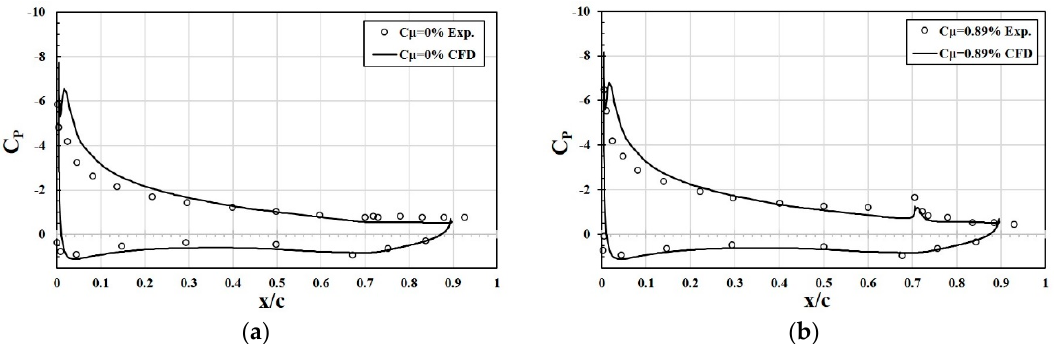
Figure 8. Validation of numerical results for pressure coefficient using experimental data (Melton et al. [18]) for the NACA 0015 airfoil with a flap and fluidic oscillators (x 0 /c = 0.7, α = 8°, δ f = 40° and y/s = 0.5) performed by Kim and Kim [29]. ( a ) Case I and ( b ) Case II. Table 4. Validation of numerical results for lift coefficient using experimental data (Melton et al. [18]) for the NACA 0015 airfoil with a flap and fluidic oscillators (x 0 /c = 0.7, C µ = 2.15%, α = 8 ◦ , δ f = 40 ◦ ). Angle of Attack ( α